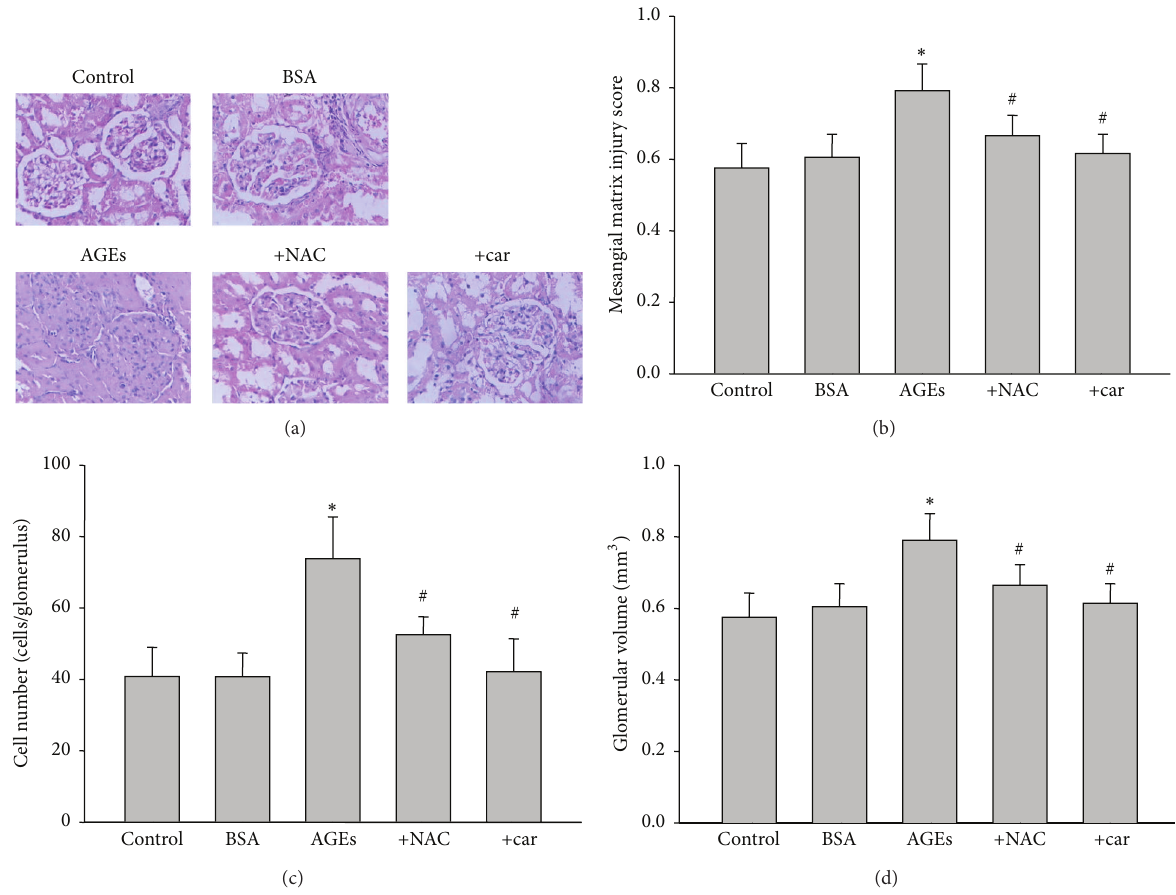
Figure 3: Inhibition of NHE1 improves AGEs-induced abnormality of glomerular structure in rats. The rats received a tail vein injection of AGEs (100mg/kg) followed by treatment with or without N-acetylcysteine (200 mg/kg/day) or cariporide (1mg/kg/day) for 12 weeks. At the end of experiments, rats were sacrificed under anesthesia. (a) Morphology of glomerular in kidney by HE staining. (b) Mesangial matrix injury score, (c) cell numbers in glomerular, and (d) glomerular volume were determined. Data are expressed as mean ± S.E.M. 𝑁 is 10–15 in each group. ∗ 𝑃 < 0.05 versus BSA. # 𝑃 < 0.05 versus AGEs